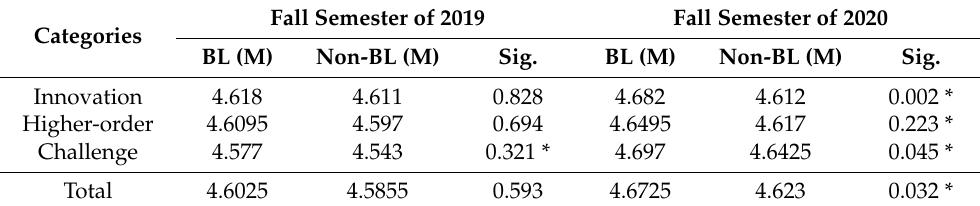
Table 5. Course evaluation of S University ( n = 60).